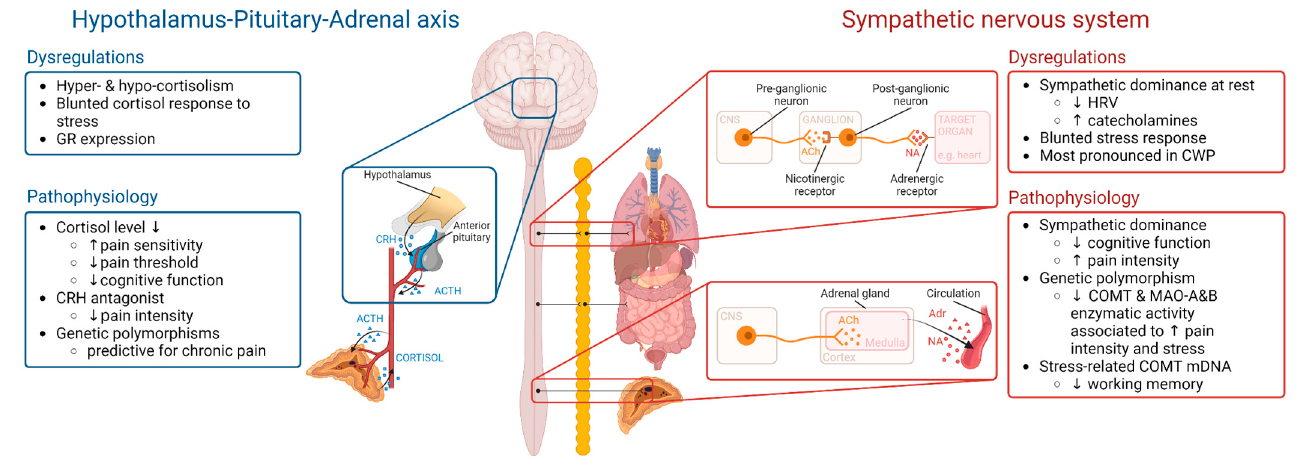
Figure 1. Visual representation of the major stress pathways, together with common dysregulations in chronic pain and their possible pathophysiological implications in stress intolerance. ↑ , Increased; ↓ , Decreased; ACh, Acetylcholine; Adr, Adrenaline; ACTH, Adrenocorticotropic hormone; COMT, Catechol-O-methyltransferase; CNS, Central nervous system; CWP, Chronic widespread pain; CRH, Corticotropin-releasing hormone; mDNA, DNA methylation; GR, Glucocorticoid receptor; HRV, Heart rate variability; HPA axis, Hypothalamic-pituitary-adrenal axis; MAO-A&B, Monoamine oxidase A&B; NA, Noradrenaline. Created with BioRender.com. (Accessed on 9 February 2023).